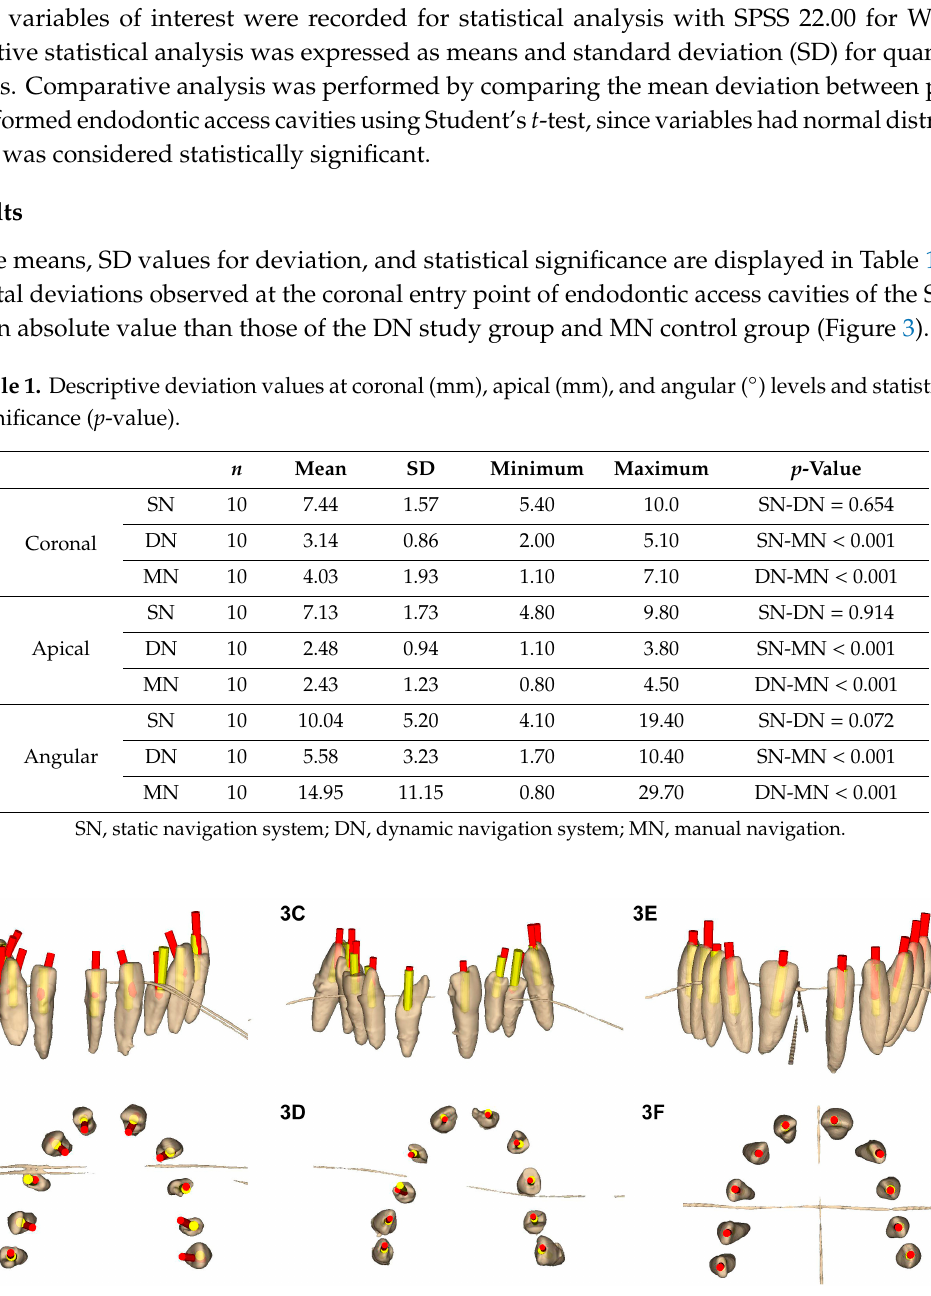
Figure 3. ( A , B ) Planned endodontic access cavities (yellow cylinders) and access cavities performed manually (red cylinders). Guided endodontic access cavities planned and performed through ( C , D ) computer-aided static navigation system and ( E , F ) computer-aided dynamic navigation system.